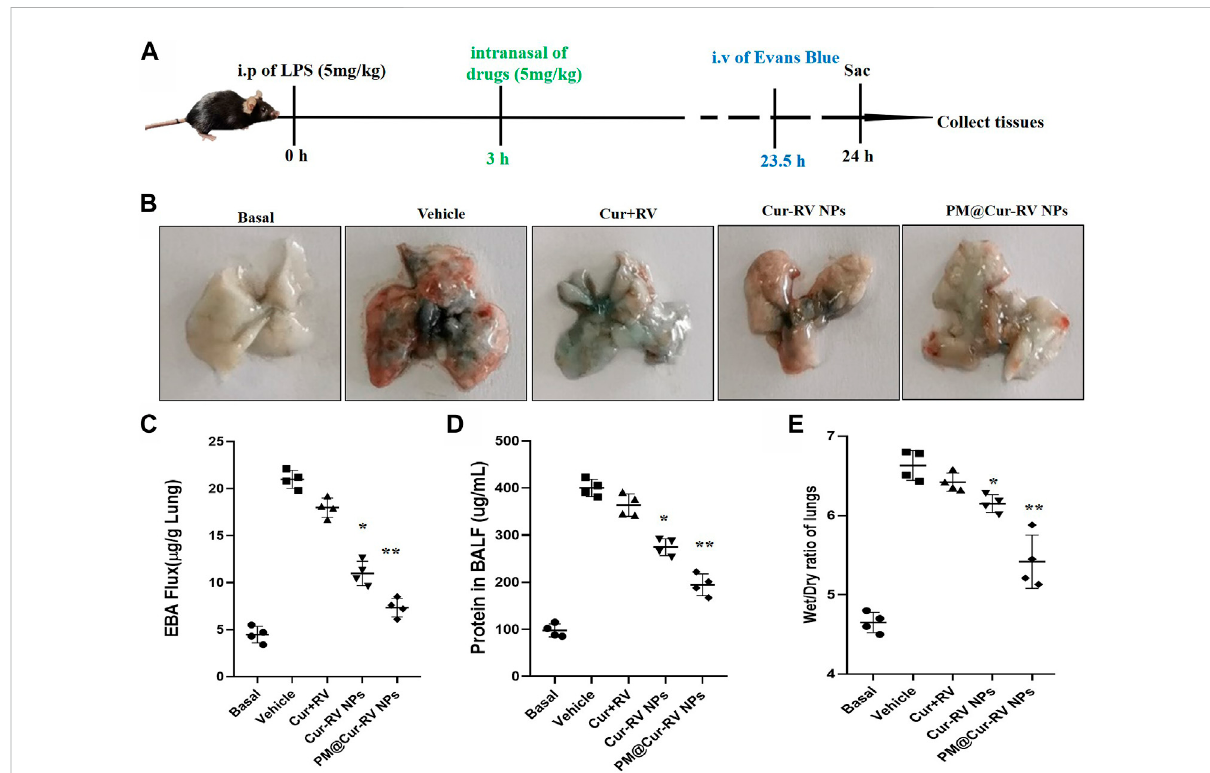
FIGURE 4 Cur-RV NPs, especially PM@Cur-RV NPs signi fi cantly inhibit lung vascular permeability in LPS-challenged mice. (A) Time-axis of lung vascular permeabilitydeterminedbyEBA(Evansblue-conjugatedalbumin)extravasationassay.At3 hpost-LPSchallenge(5 mg/kg,i.p.),drugs(5 mg/kg,i.n.) were administered to mice. The same volume of PBS (5% of DMSO were included) was administrated to a group of mice as controls. Lungs were collected at 24 h post-LPS challenging for quantitative tests. (B) Representative photos demonstrated that curcumin-NPs could signi fi cantly inhibited lung vascular injury comparing with that of curcumin group. At 24 h post-LPS challenge, mouse lungs 30 min after i. v. Of EBA were perfused to remove blood and imaged. (C) The amounts of Evans Blue (EB) fl uxed in lungs were assayed to evaluate the permeability of lung vessels. (D) The quantitative analysis of protein level in broncholveolr lvge fl uid (BALF) of mice treated with different formulations of Cur and RV. (E) The wet/ dryratiooflungsfromLPS-challengedmicetreatedwithdifferentformulationsofCurandRV.Datawereexpressedasmean±SD(n=4/group).* p < 0.05, ** p < 0.001 versus vehicle